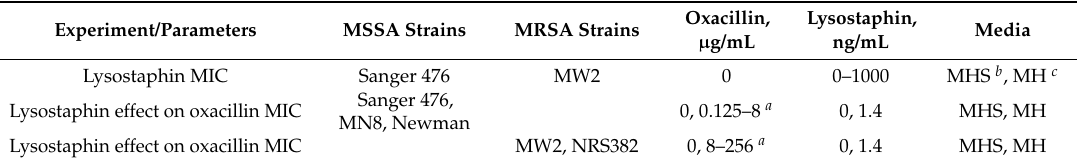
Table 2. Summary of